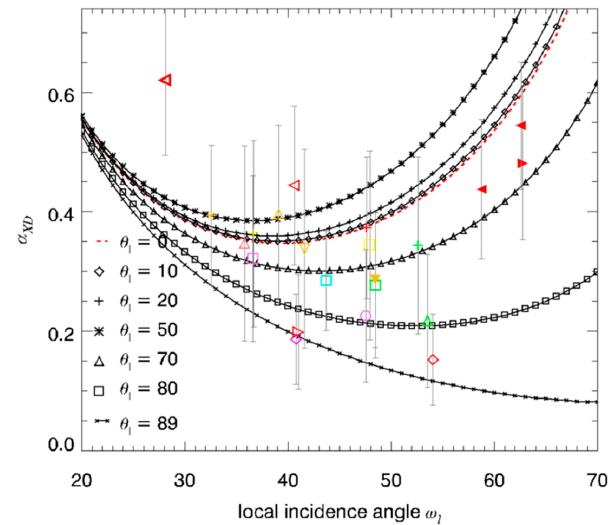
Figure 29. Comparison of α XD from extended Fresnel scattering (black lines) and from standard Fresnel scattering (red dashed line) along the local incidence angle ω l ; α XD is derived from the X-Fresnel model with ε s -input from local field measurements ( ε s = 10, ε t = 25, ϕ = 0°) for different roughness angles θ 1 and from the AgriSAR (plus (June) and triangle up (July) sign), OPAQUE (square sign), SARTEO (diamond sign) and TERENO (triangle down = Bode site, triangle right Demmin site E-W track, triangle left Demmin site N-S track) L-band data for several agricultural fields with a stalk- dominated phenology (yellow = winter barley, green = field grass, gold = winter wheat, pink = winter wheat (field 221), cyan = grassland, red = undefined land use, orchid = winter triticale); gray bars indicate the standard deviation of α XD for each of the agricultural fields.